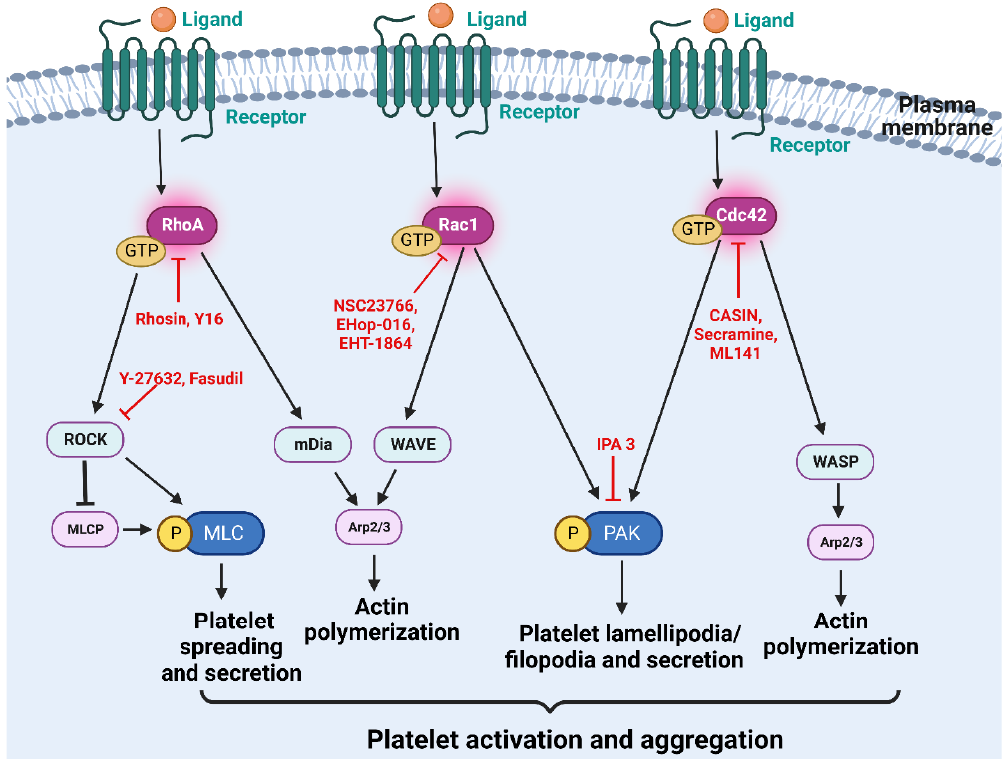
Figure 3. Pharmaceutical targeting of Rho GTPases as an antiplatelet approach. Various pharmaco- logical inhibitors have been developed to selectively target critical components of the Rho GTPase signaling pathways and inhibit platelet activation. RhoA inhibitors such as Rhosin, Y16, and ROCK inhibitors such as Y27632 and Fasudil have been used to study the role of RhoA in platelet function. NSC23766, EHop-016, and EHT-1864 inhibit the activation of Rac1, while CASIN, Secramine, and ML141 inhibit the activation of Cdc42 to study their roles in platelet activation. IPA 3, an inhibitor of PAK, is used to elucidate the role of PAK in platelet function.